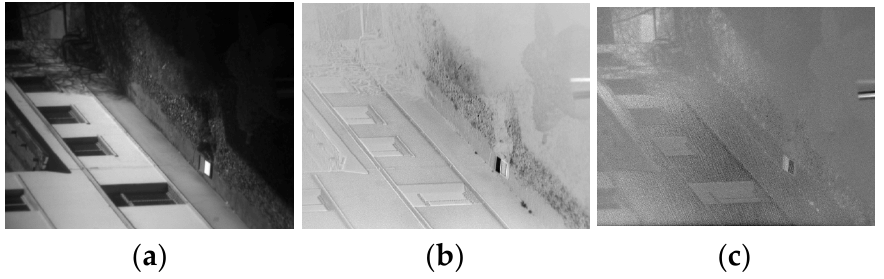
Figure 13. The first three principal component images after the PCA of the whole image in the first set of experiments. ( a ) The first principal component image, ( b ) The second principal component image, ( c ) The third principal component image.